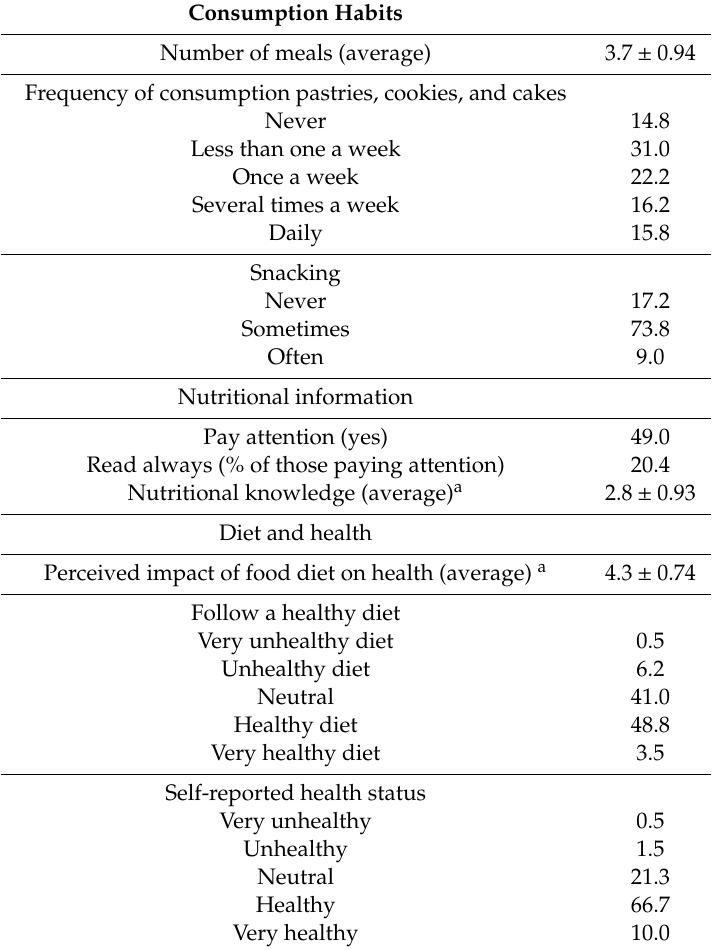
Table 2. Food consumption and health habits (%, unless